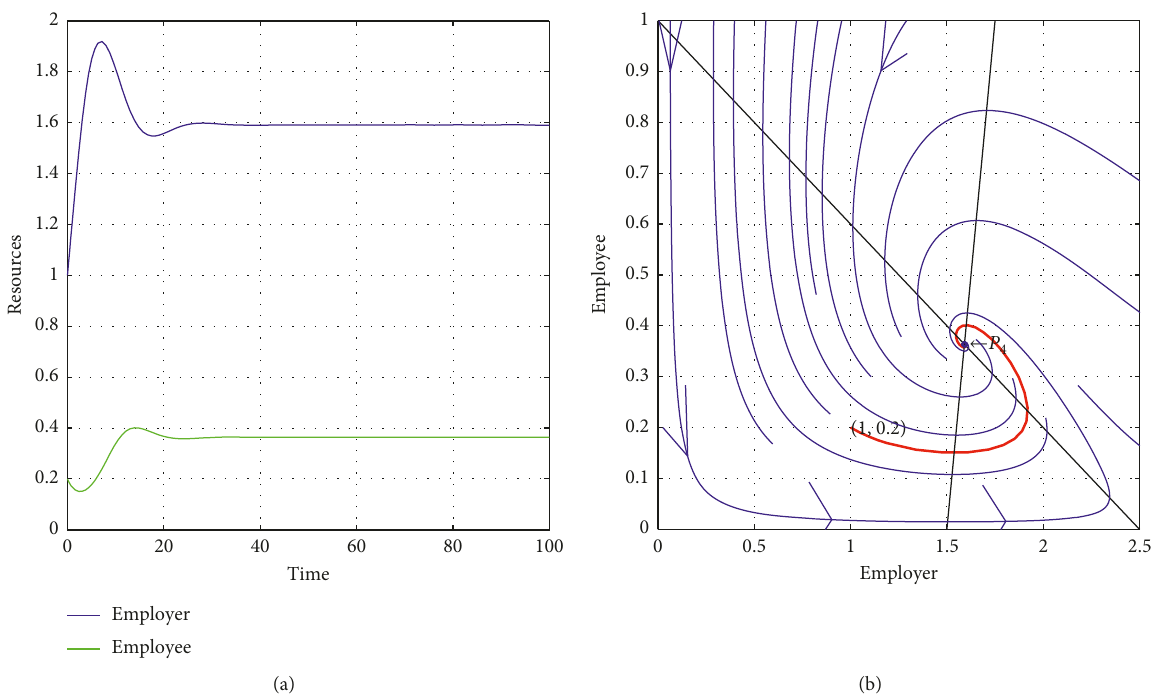
Figure 8: The simulation result and the phase diagram in the win-win situation ( b